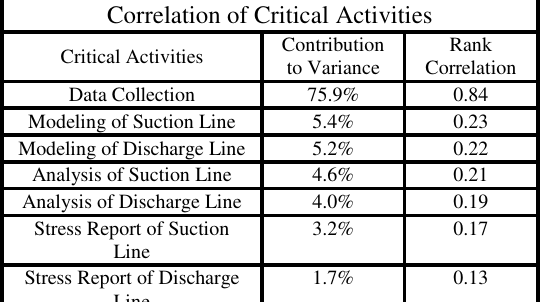
Fig. 5: Correlation between Stress Report of Suction Line and Total Man Hours Table 10: Contribution to Variance and Rank